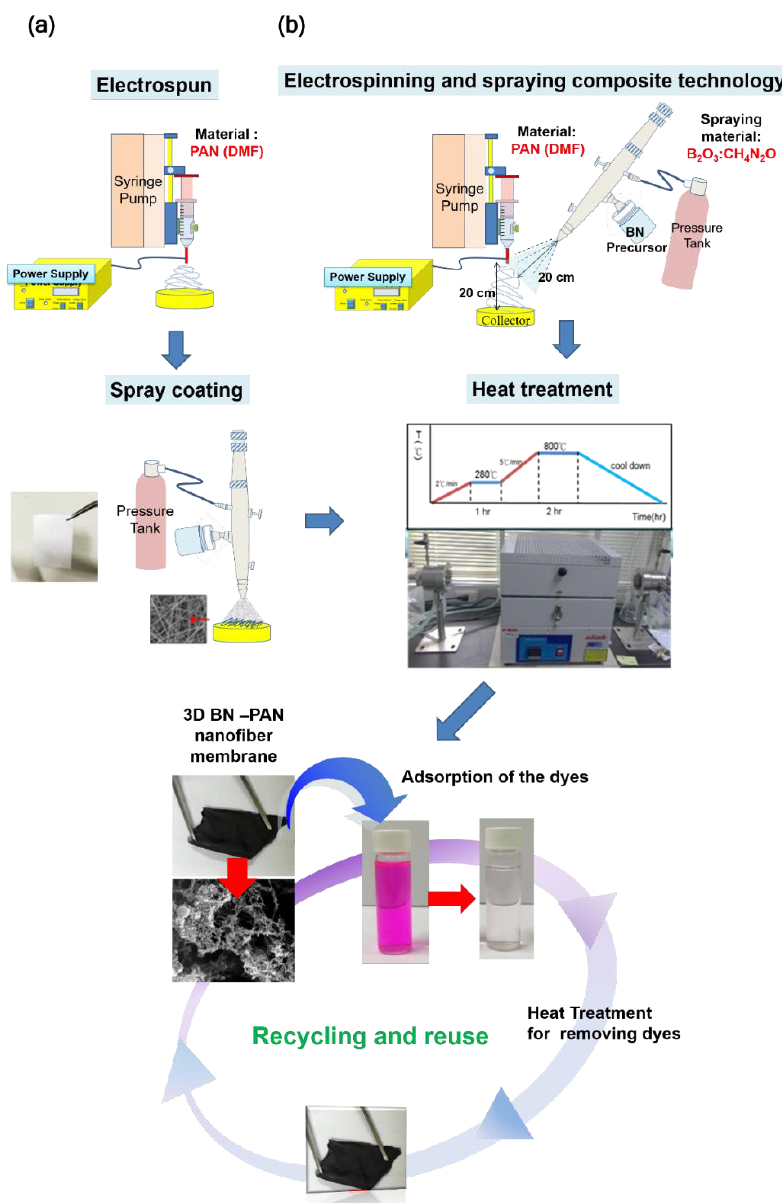
Figure 1. The process to produce the boron nitride (BN)- polyacrylonitrile (PAN) electrospinning (ES) polymer nanofibers (NFs): ( a ) spray-coating BN precursor to PAN NFs. ( b ) directly spray coating BN precursor and electrospinning PAN NFs at the same time.